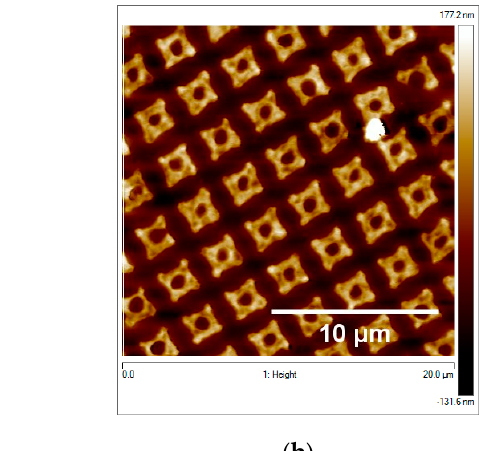
nano-inclusions; ( b -top) magnetic susceptibility as function of temperature for Co-based